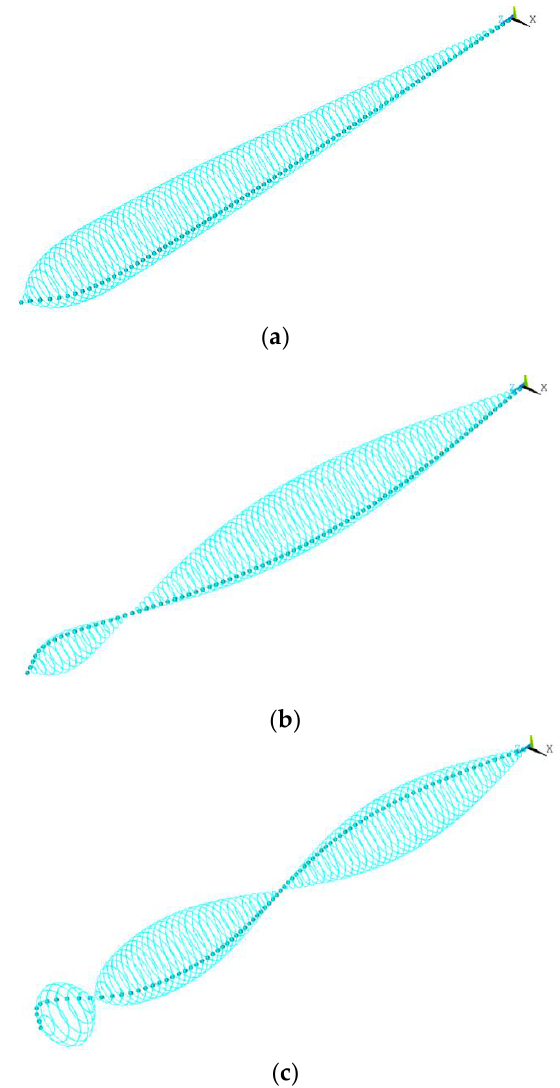
Figure 5. Orbits of the drill-string at the first three modes. ( a ) f = 0.0325 Hz (0.032 Hz, Khuleif et al. [8,15]); ( b ) f = 0.0675 Hz (0.0677 Hz, Hhuleif et al. [8,15]); ( c ) f = 0.111 Hz (0.078 Hz, Khuleif et al. [8,15]).